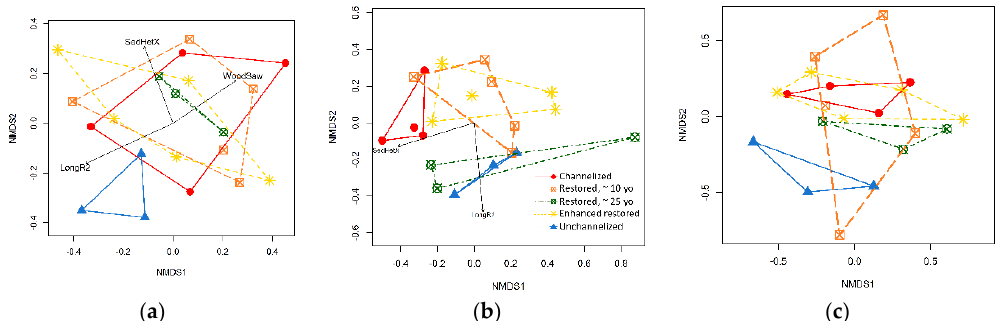
Figure 4. Axes 1 and 2 of NMDS ordinations for assemblages of macroinvertebrates ( a ), diatoms ( b ), and macrophytes ( c ) for all sites ( n = 20). Analyses were based on Bray–Curtis dissimilarity index on transformed abundance data for macroinvertebrates and diatoms, and Raup–Crick dissimilarity index on presence–absence data for macrophytes. Each point represents the community composition of a different site. We have delineated the extent of the range in variation for each status with different line colors that match the color of the points. Arrows show strength and direction of significant correlations of geomorphic complexity variables with the ordination space (LongR 2 = variation in longitudinal profile, SedHetX = variation in smaller and larger—extreme—sediment sizes, WoodSaw = volume of instream wood cut by a saw). There were no significant correlations of geomorphic complexity with macrophytes.